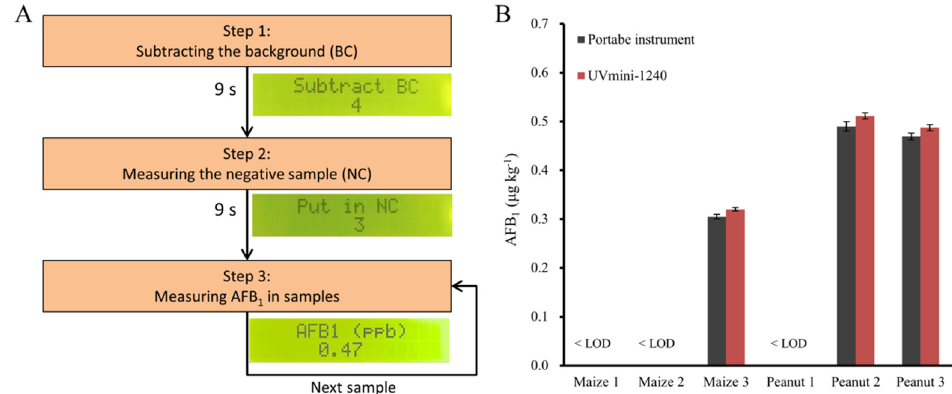
Figure 6. Rapid quantification of AFB 1 in food samples. ( A ) Schematic illustration of the rapid quantification by using the portable instrument. Insets were the screenshots taken during steps 1, 2 and 3, respectively. ( B ) Detection of AFB 1 in real samples ( n = 3).